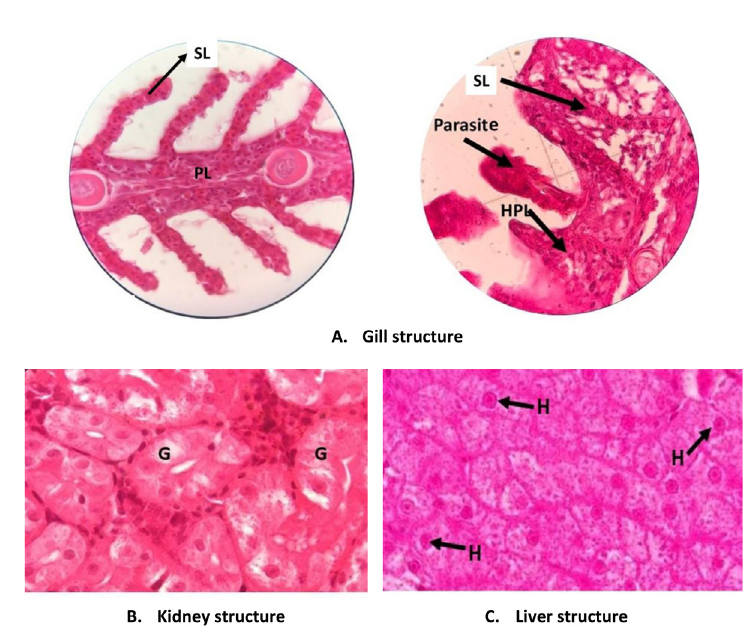
Figure 3. Tissue structure of P. hypophthalmus reared under manipulated photoperiod. PL: primary lamellae; SL: secondary lamellae; HPL: hyperplasia; G: glomerulus; H: hepatocyte cells.